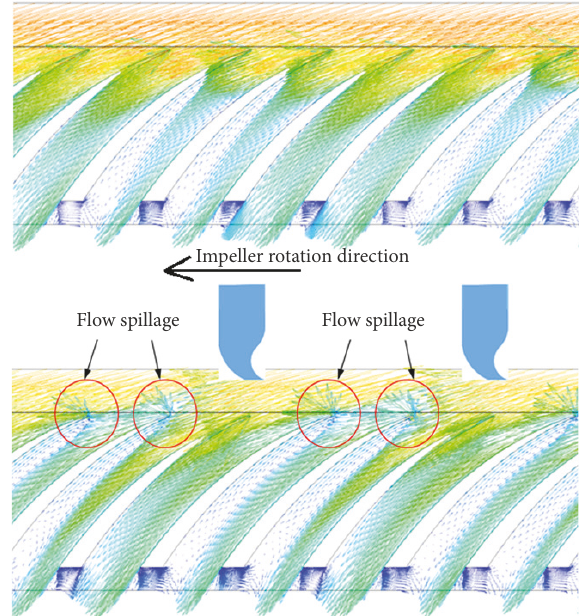
Figure 19: Surface streamline at 0.9 span around the diffuser